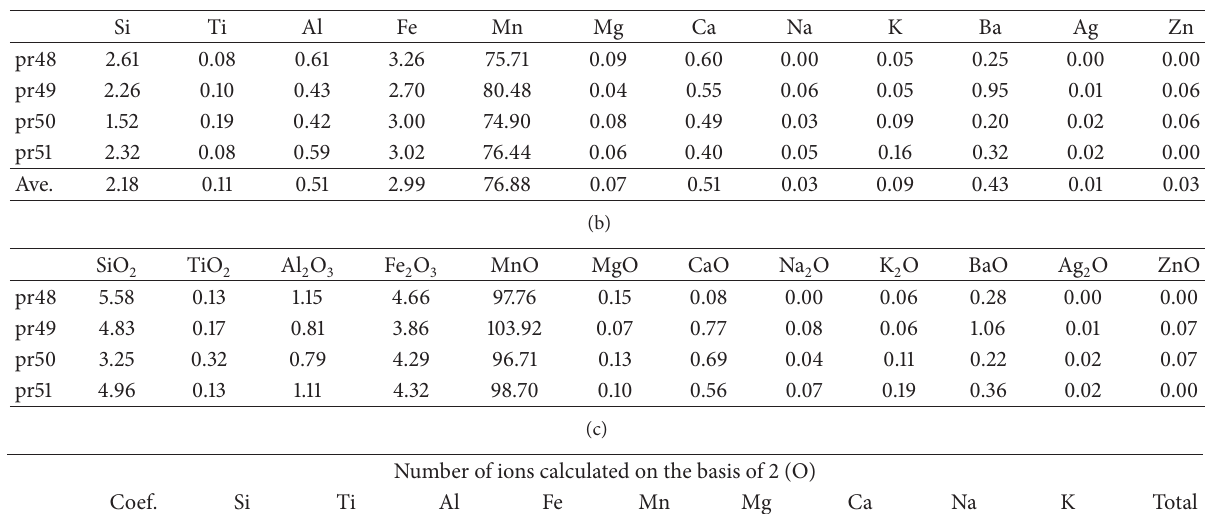
Table 4: Composition of pyrolusite (pr) samples of Buyukmahal ore. (a)